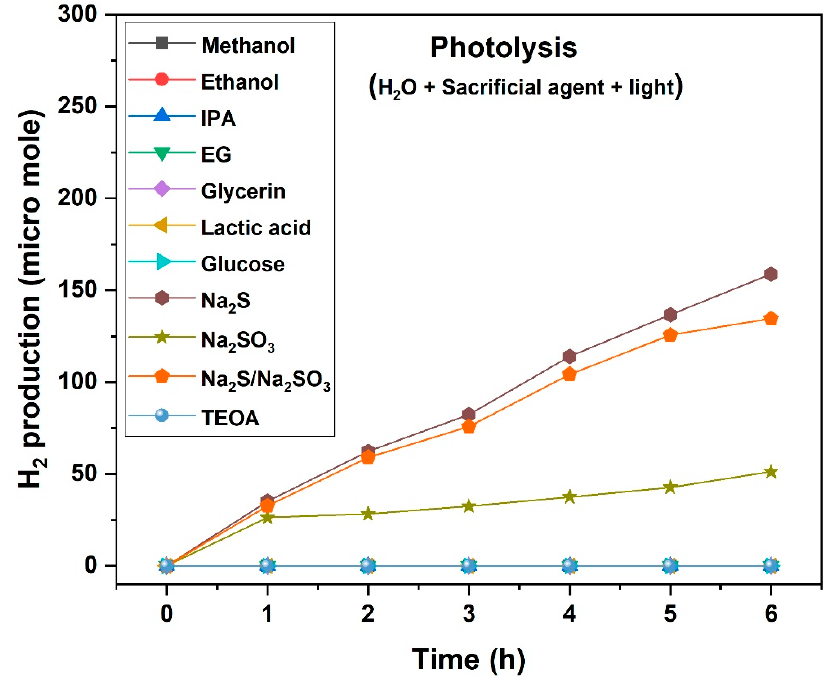
Figure 5. H 2 production efficiency of sacrificial agents without photocatalyst (photolysis).